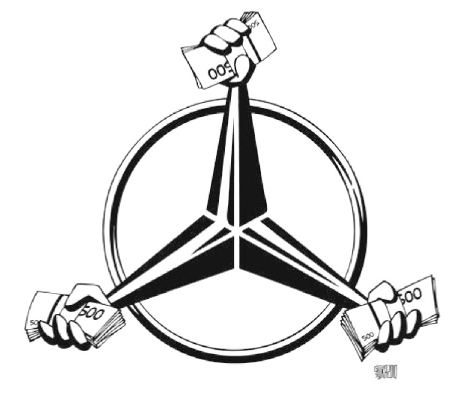
Fig. 6. Author: Gatis Š ļū